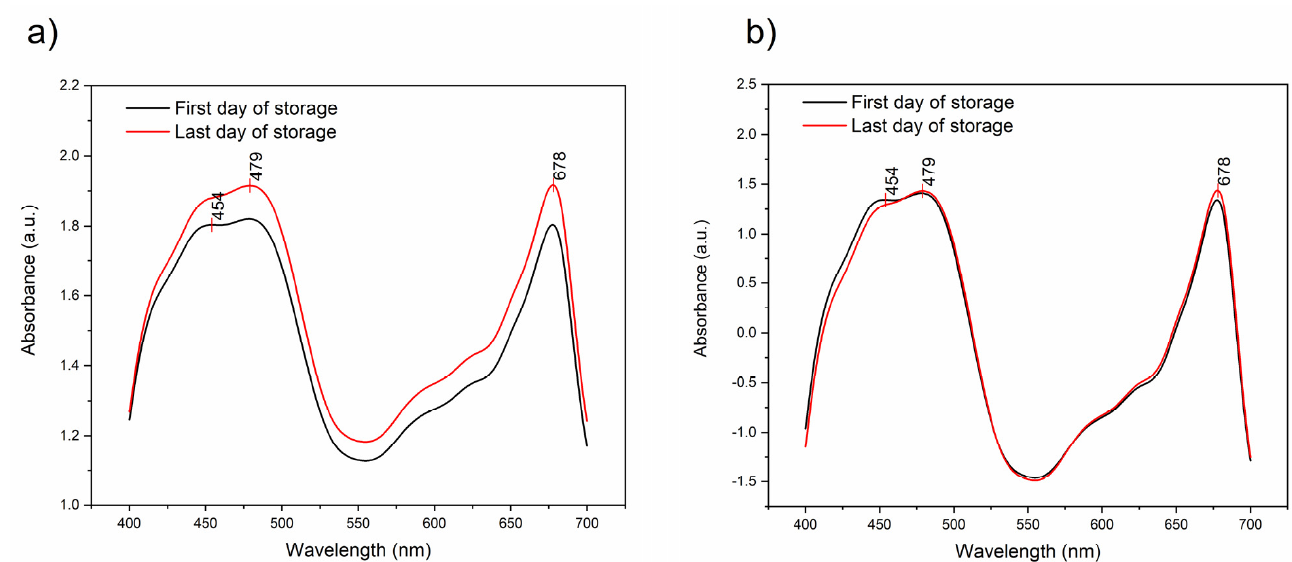
Figure 3. The changes in the visible part of the spectra. ( a ) Raw spectra: comparison of average spectra of lettuce leaves acquired on the first and last day of storage; ( b ) SNV-transformed spectra: comparison of average spectra of lettuce leaves acquired on the first and last day of storage.